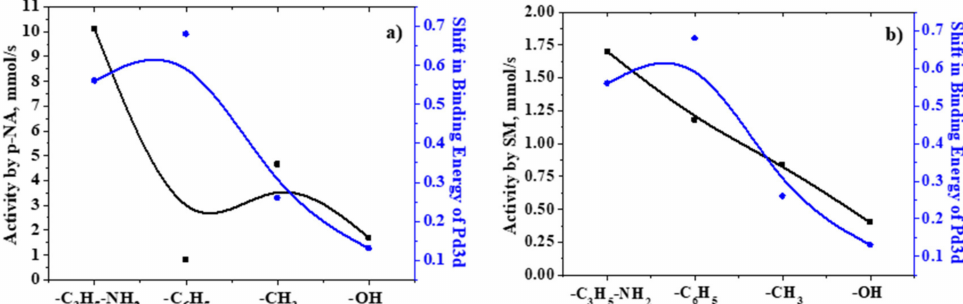
Figure 15. Dependences of the catalysts activity in the hydrogenation of 4-nitroaniline ( a ), sodium maleate ( b ), and the value of the binding energy shift Pd o on the functional groups nature on the support